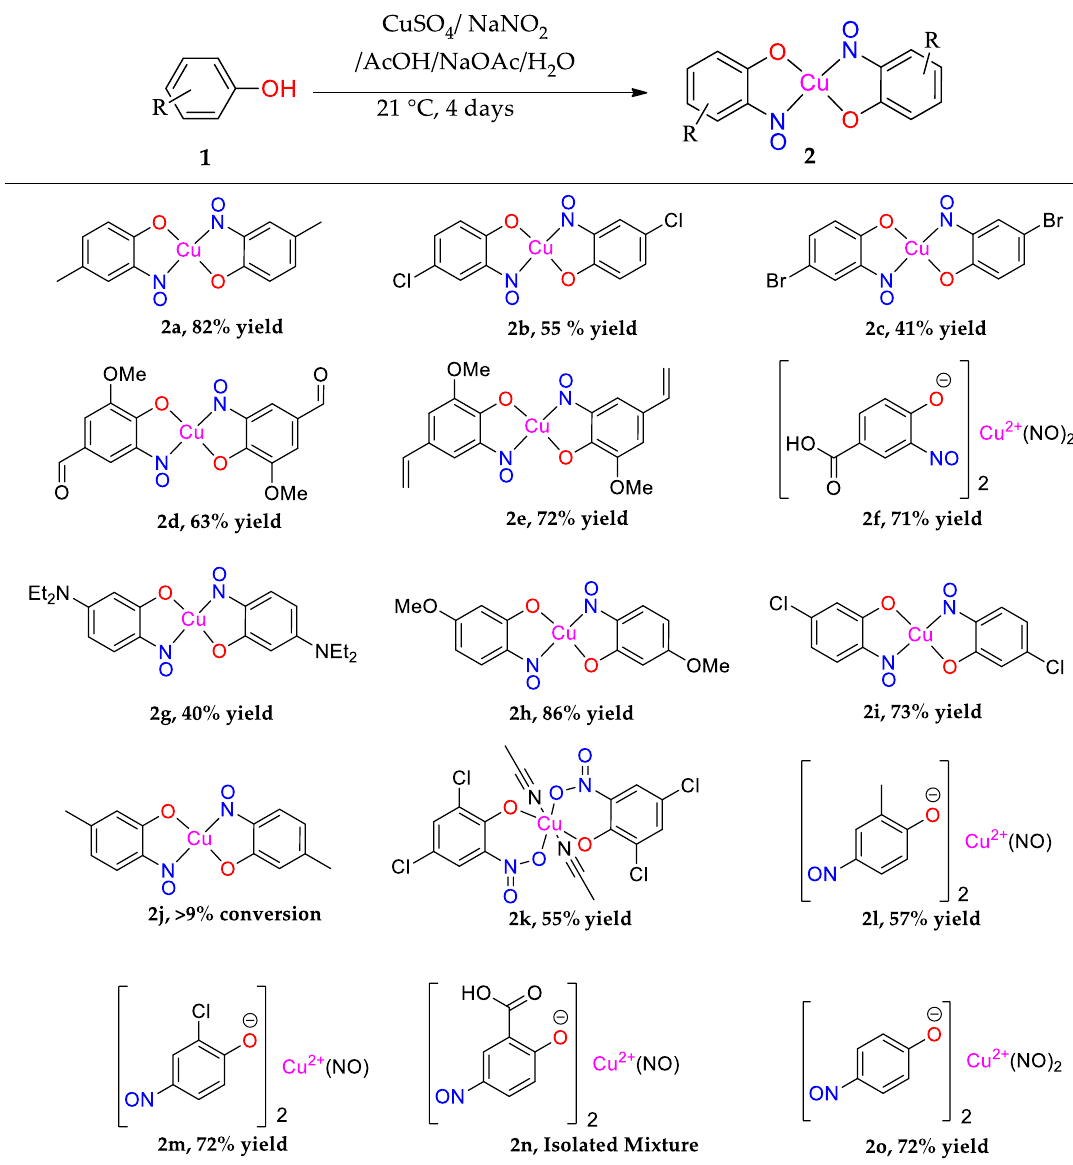
Table 1. Copper-mediated nitrosation of substituted phenols.